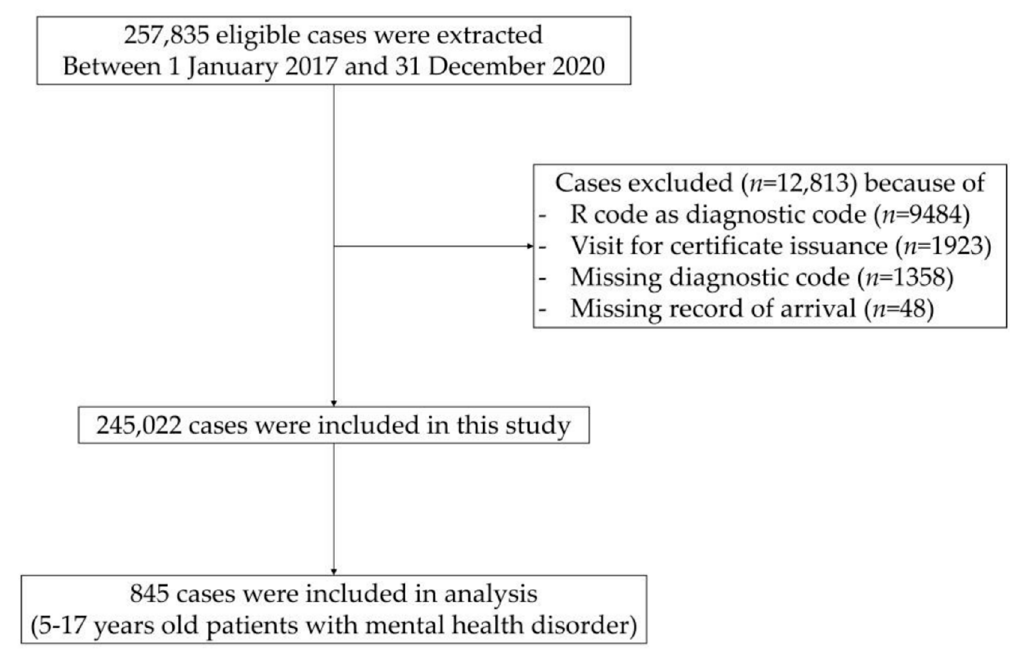
Figure 1. Flowchart of the study population.